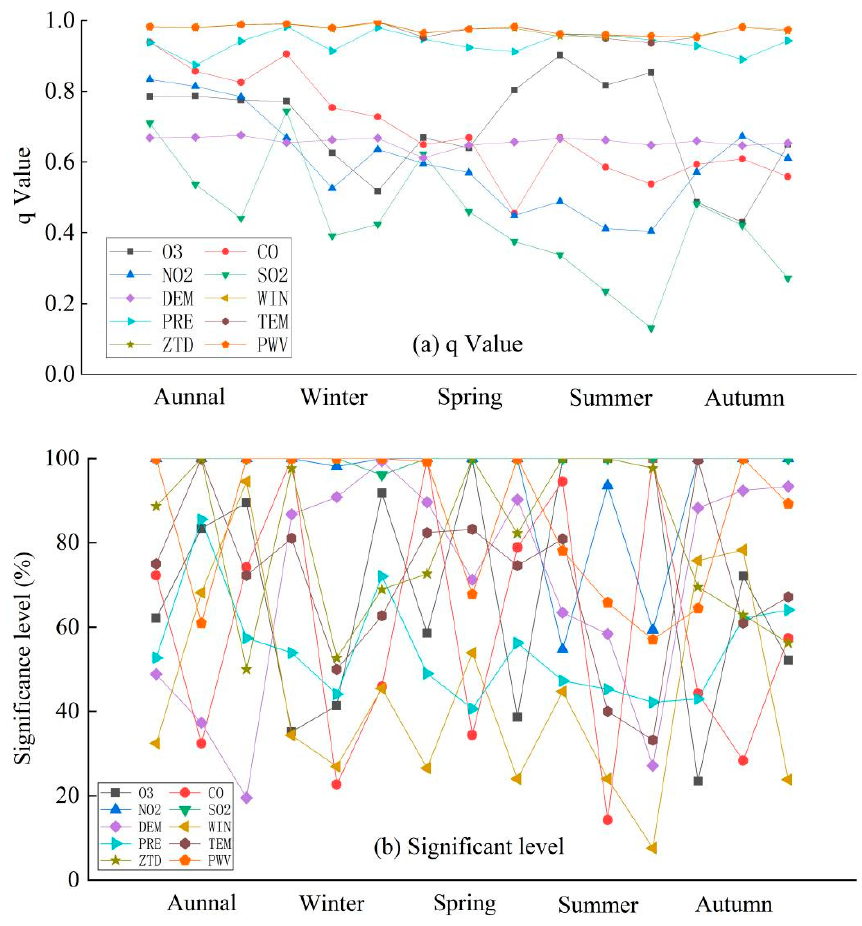
Figure 9. Variable correlation degrees: ( a ) q values, ( b ) significant levels.